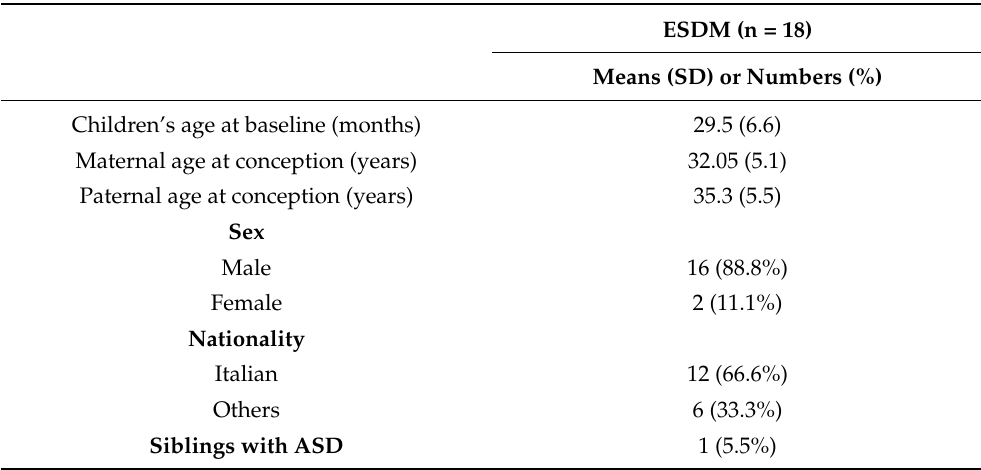
Table 1. Demographic characteristics of the sample .